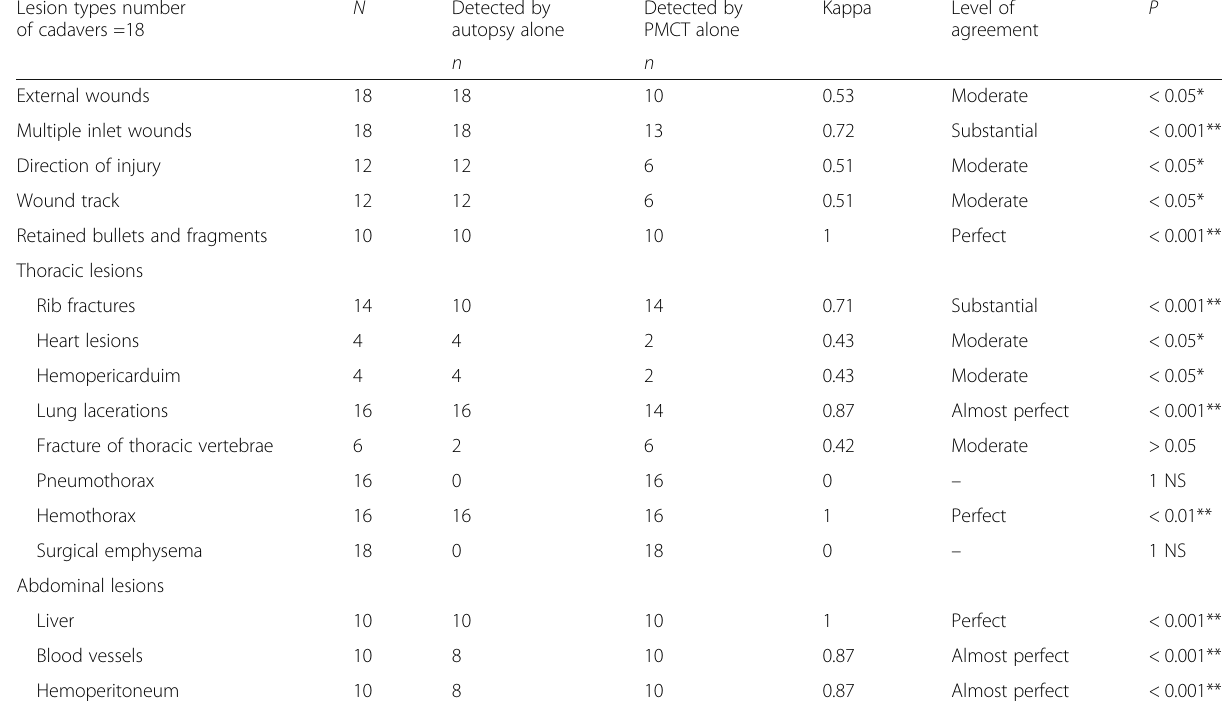
Table 2 Degree of agreement between PMCT and autopsy in detection of injuries in cases of multiple firearm injuries in the chest and abdomen by Cohen ’ s Kappa test